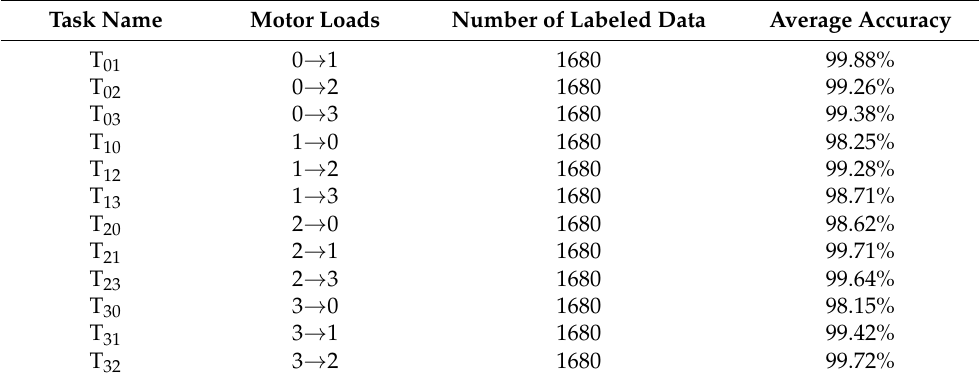
Table 4. Comparison